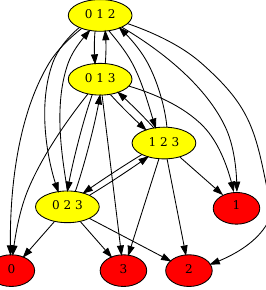
Figure 4: Example graph illustrating the connection between triplets and cameras.